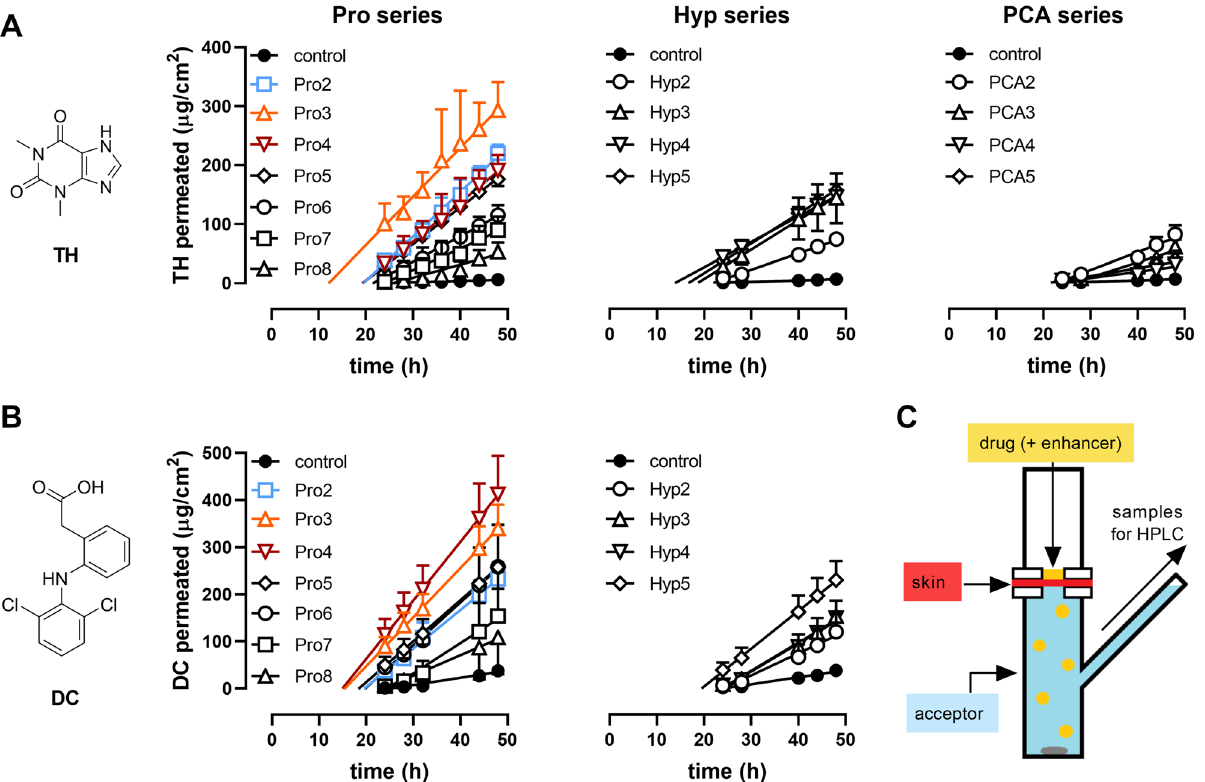
Figure 2. The effects of the studied Pro, Hyp and PCA derivatives on the permeation of the model drugs (infinite dose) theophylline (TH, applied as 5% suspension in 60% PG, A ) and diclofenac (DC, applied as 3% solution in 60% PG, B ) through human skin, and the scheme of modified Franz diffusing cell used in the experiments ( C ). Data are presented as the means ± SEM; n ≥ 3. For flux values and statistical significance,